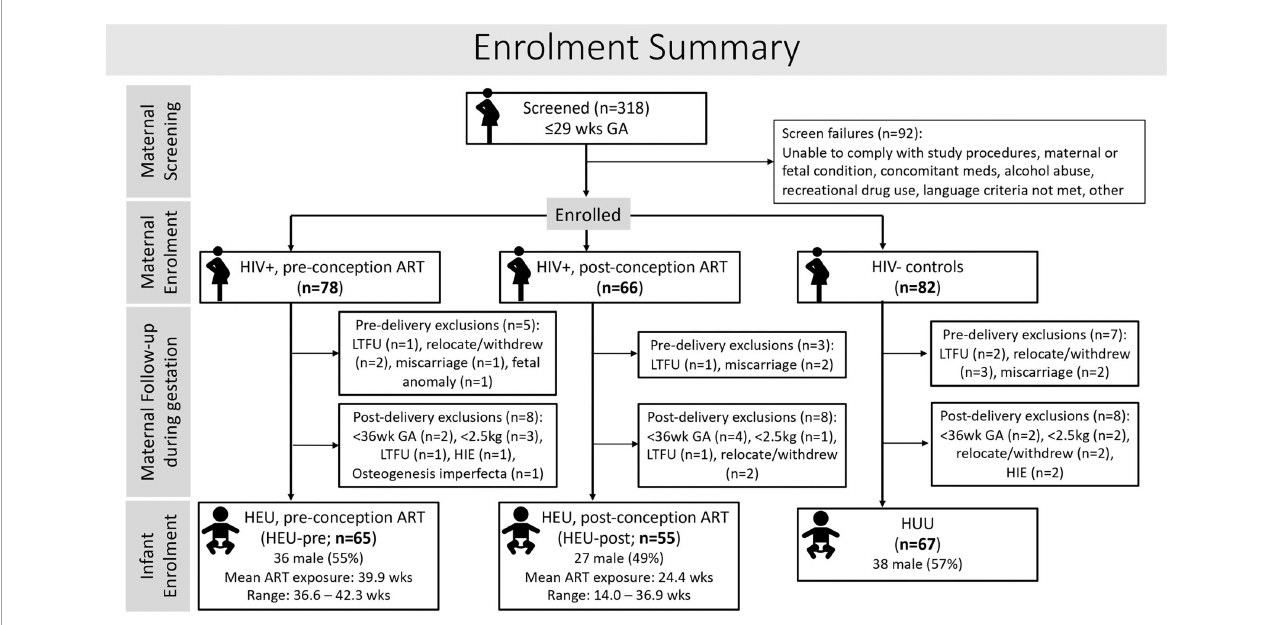
FIGURE1 Flow diagram showing maternal and infant participant and exclusion numbers at each stage of the